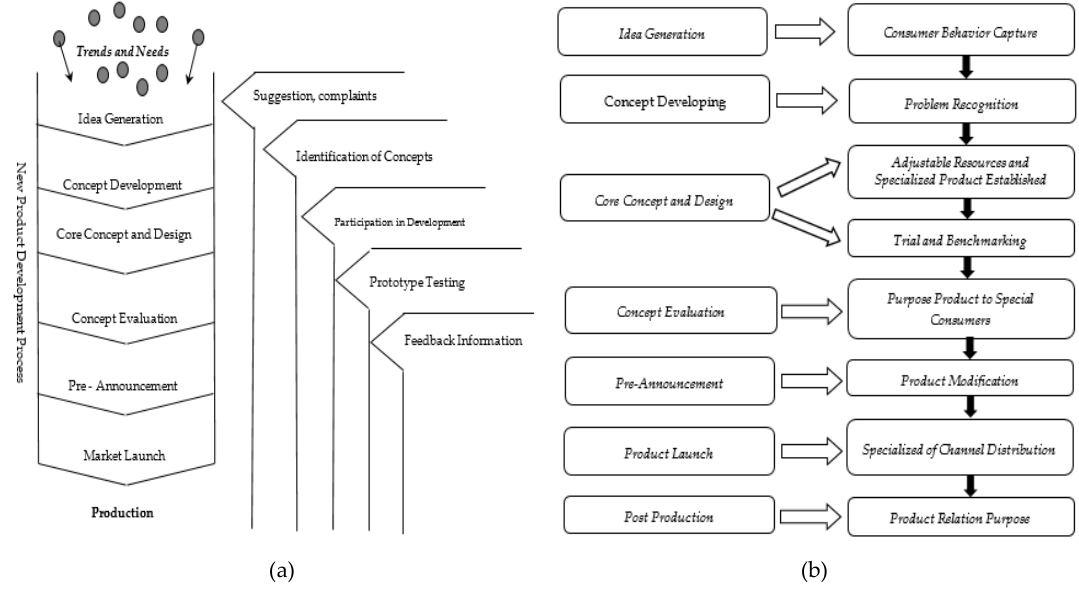
Figure 1. Differences in the stages of new product development with active problems and with Figure 1. Di ff erences in the stages of new product development with active problems and with inactive inactive issues. (a). the stages of product development with an active problem perspective [19]; (b). issues. ( a ) The stages of product development with an active problem perspective [19]; ( b ) The stages the stages of product development with an inactive problem perspective. of product development with an inactive problem perspective. Table 1. Di ff erences between inactive problems and active